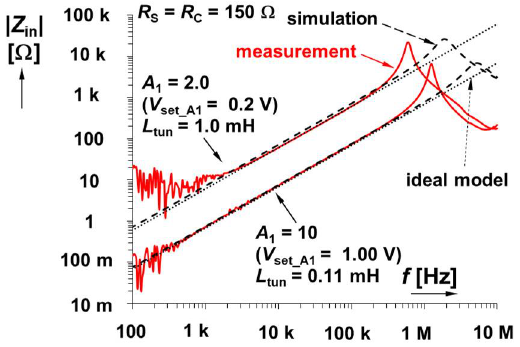
Figure 5. Magnitude impedance plots of solution presented in Figure 2.